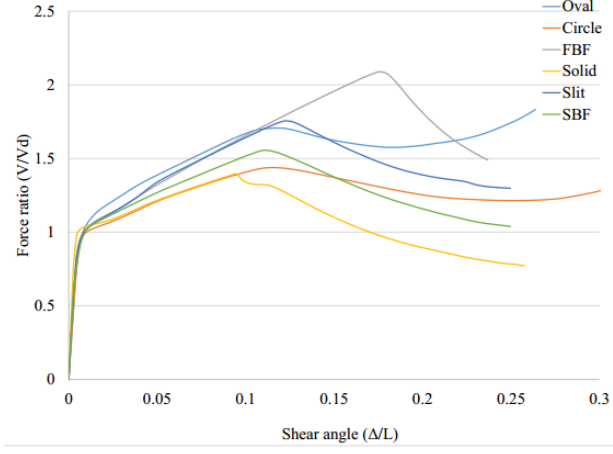
Figure 17. Pushover analyses curves for various innovative SRL fuse systems.